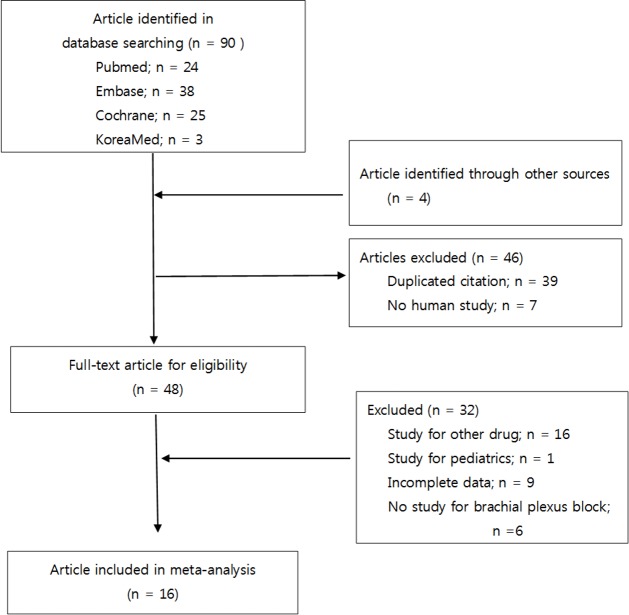
PRISMA flow diagram for the inclusion and exclusion process.